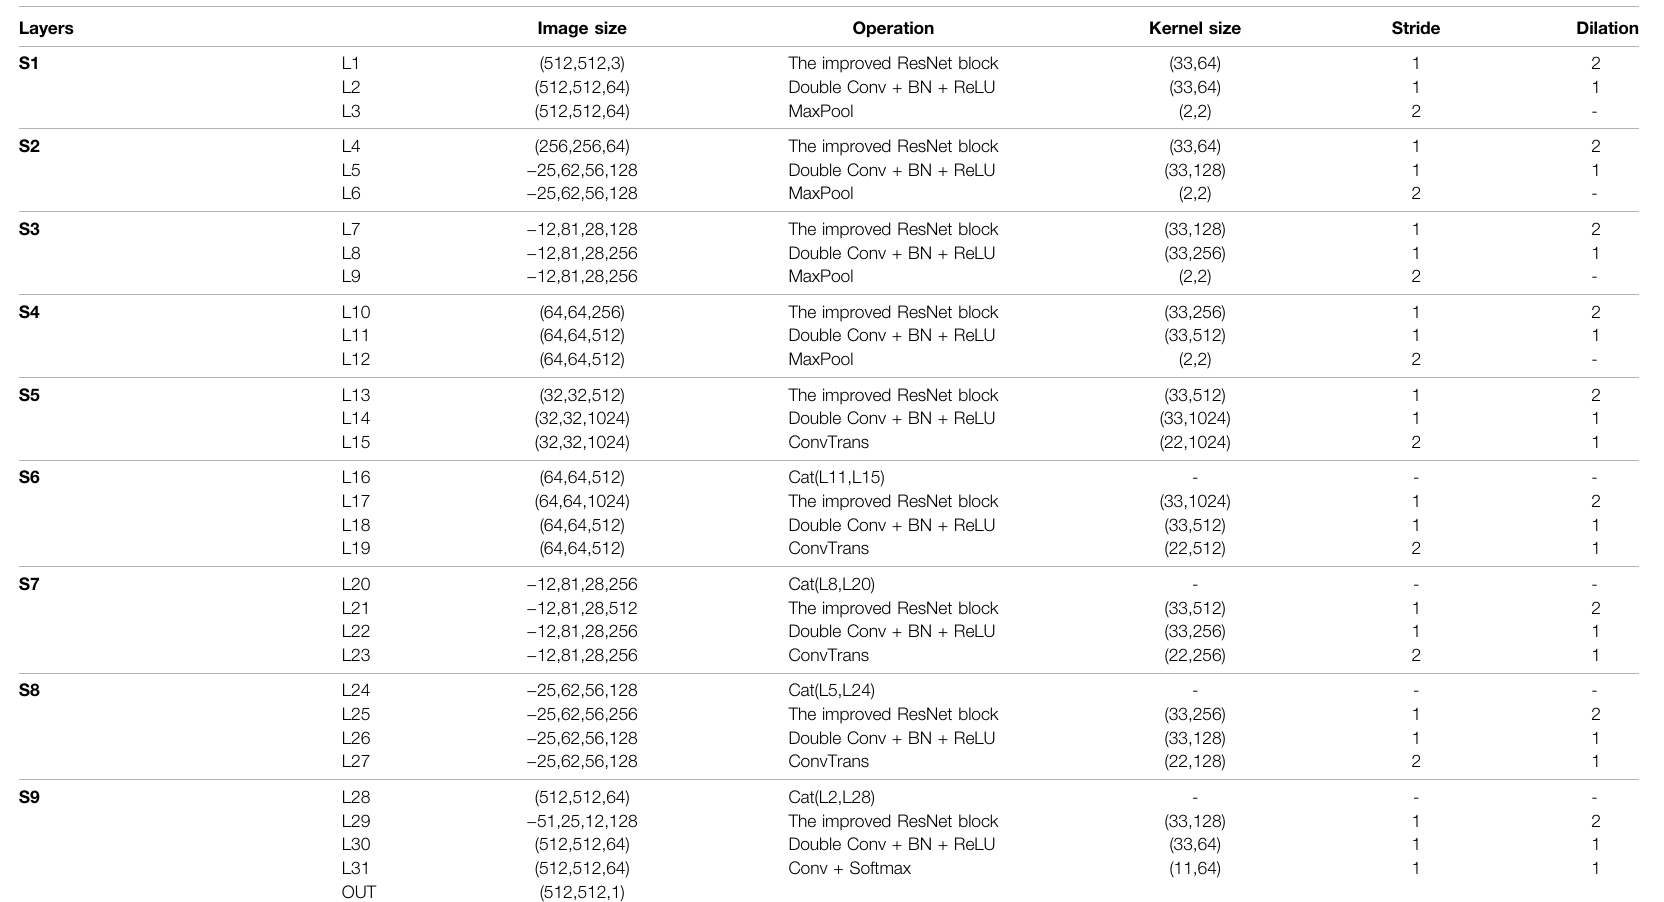
TABLE 1 | Architectural details of the improved